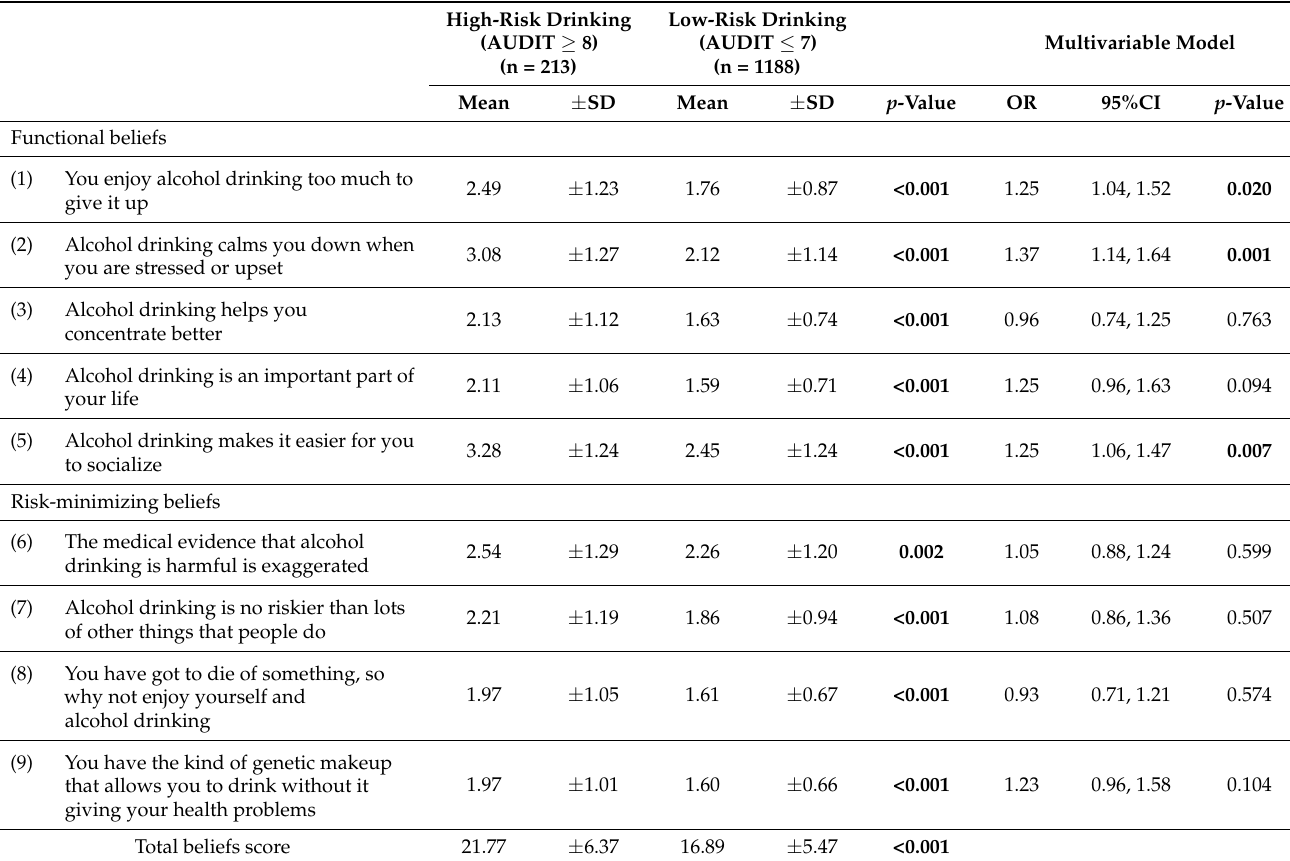
Table 2. Differences in functional beliefs and risk-minimizing beliefs between two risk